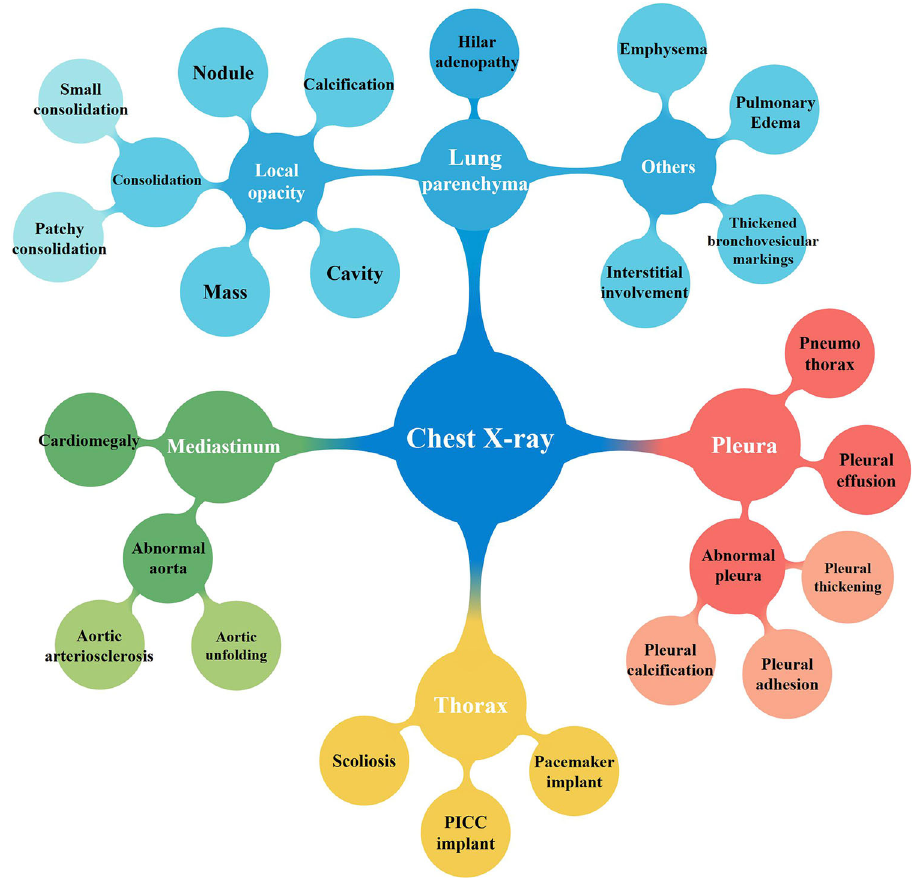
Fig. 2 Diagram of 25 labels of abnormal signs extracted from the radiology reports by the bidirectional encoder representations from transformers (BERT) model. According to the anatomical region, the linguistic entities describing abnormal signs on chest X-ray radiographs were divided into four categories: pleura, lung parenchyma, mediastinum, and thoracic wall. The words in white color refer to anatomical regions or general categories. The words in black color represent labels of abnormal